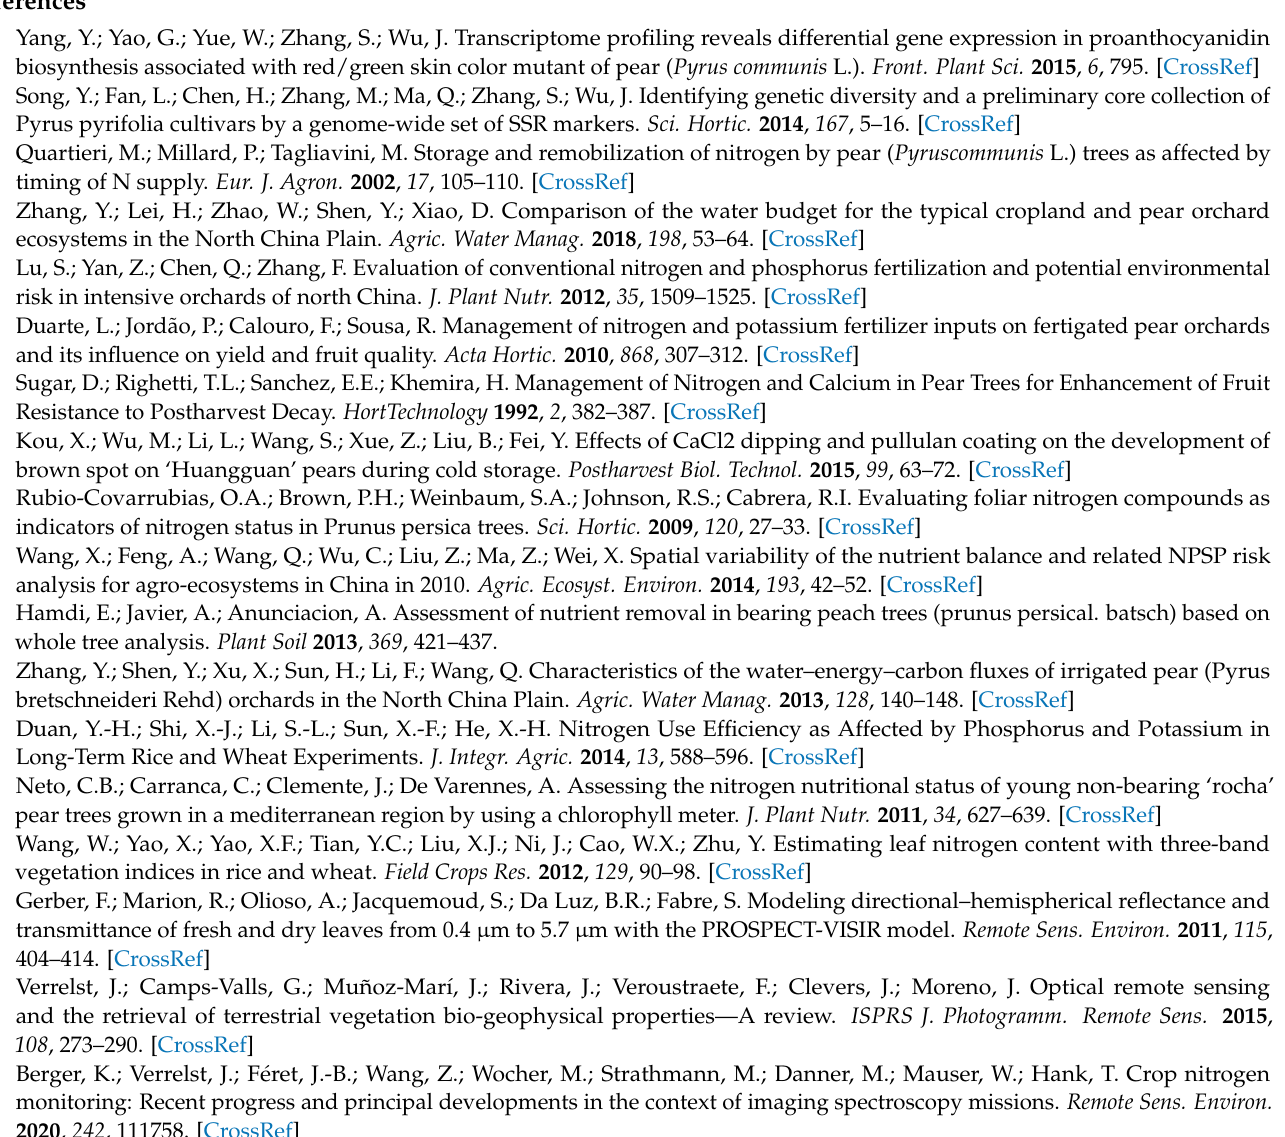
(b). Figure S4 PLSR modelling accuracy cumulated by the increment of factor number and stopped with the stable platform. Figure S5 X-loading weights of the PLSR model (the factor number was 14) calculated by all bands and normalization